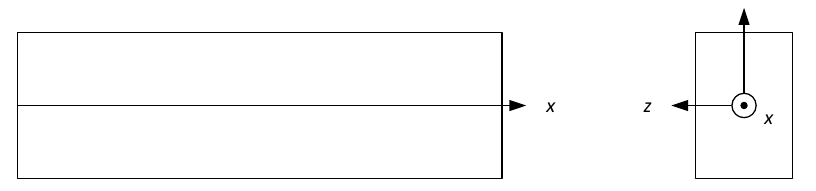
Figure 3. Coordinate system in the girder.